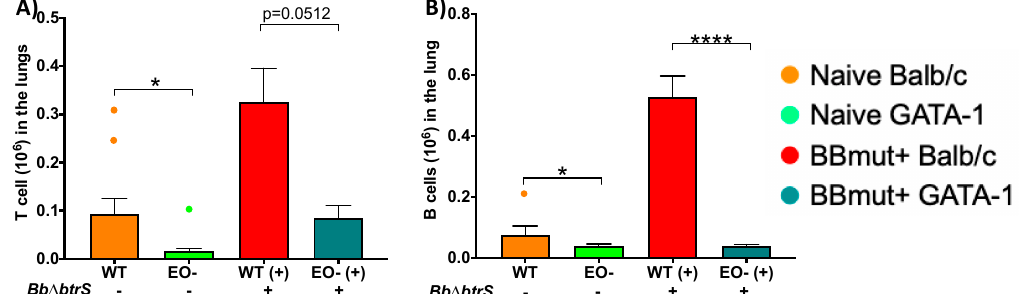
Figure 4. Eosinophil-deficient mice failed to recruit lymphocytes to the lung. WT or EO - mice were intranasally challenged with 50 µ L of PBS, or PBS containing 5 × 10 5 Bb D btrS . Mice were euthanized at day 14 post-infection, to enumerate T ( A ) and B ( B ) cell populations. WT indicates Balb / c, and EO- stands for DdblGATA-1 mice. BbD btrS indicates if intranasal challenge has been ( + ) or not (-) performed. The graphs show the average and SEM. * p < 0.05, **** p < 0.001, using two-way ANOVA. This experiment was conducted multiple independent times, to control for possible e ff ects of times of the year and spontaneous allergic reactions. n = 20.